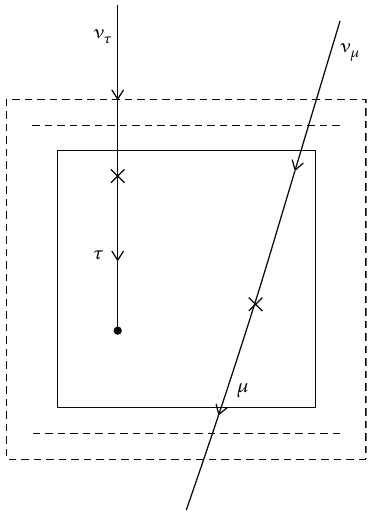
Figure 5: An illustration of the proposed underground experiment to catch cosmic tau and muon neutrinos with energy at 10TeV and above. The 100-meter size cube in the center represents the tracker and calorimeter modules as shown in Figure 4. The dashed lines are for RPC detectors. The surrounding rocks can e ff ectively enhance the target volume on top of the detector ’ s materials. Two example events are shown in the plot for ν μ ⟶ μ passing through the detector leaving a long track, and ν τ ⟶ τ with τ decay in the cube. The cross points symbol the interactions points where neutrinos turn into lepton. The dot point symbols the place where tau lepton